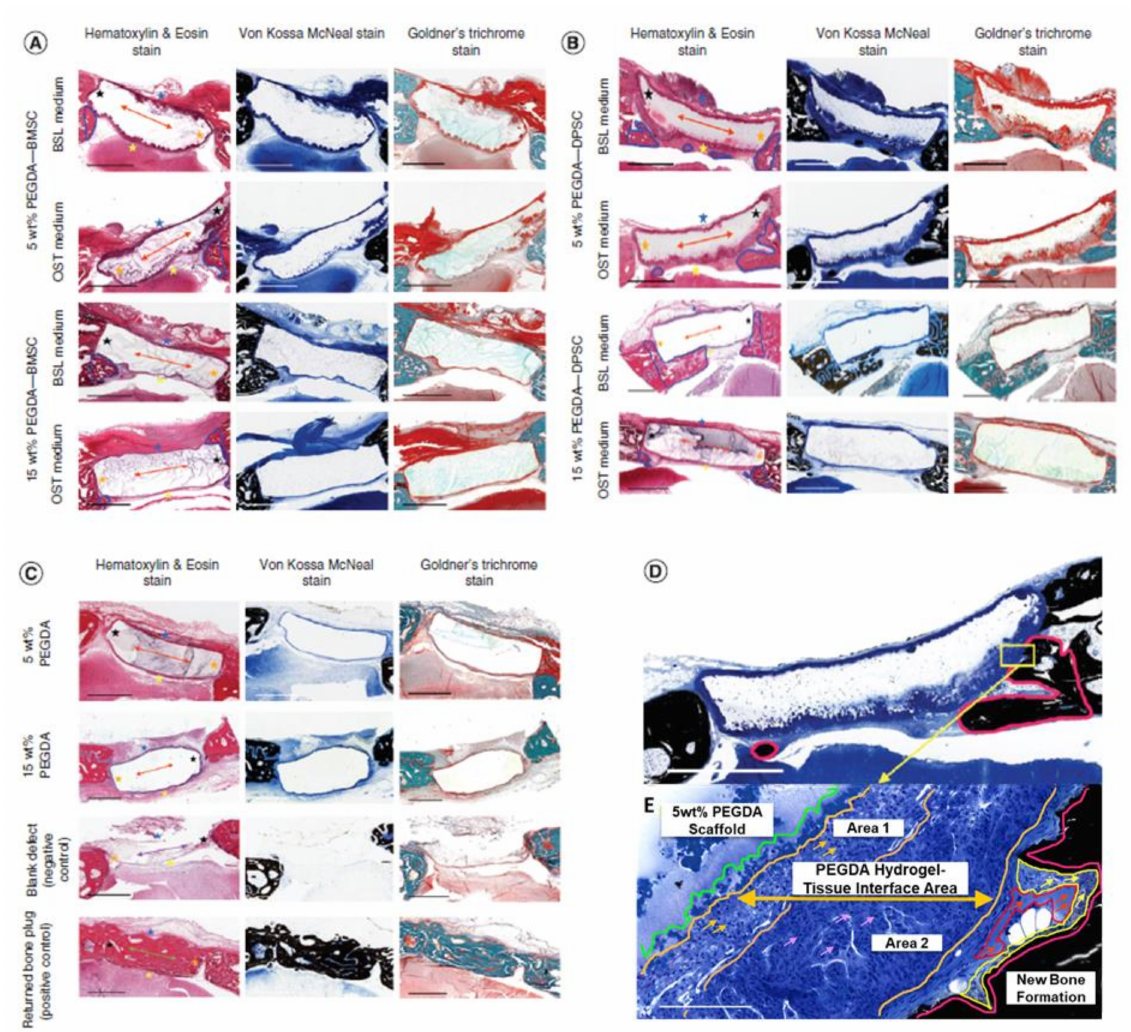
Figure 3. Histological cross-section views of retrieved specimens harvested from calvarial defect model of New Zealand White rabbits, 6 weeks post-implantation. Specimens were collected and stained with Hematoxylin and Eosin (H&E), Von-Kossa MacNeal’s, and Goldner’s Trichrome. ( A ) shows photoencapsulated-BMSCs in 5 or 15 wt% PEGDA hydrogels, cultured in basal (BSL) or osteogenic (OST) medium for 3 days prior to surgery. ( B ) shows photoencapsulated-DPSCs in 5 or 15 wt% PEGDA hydrogels, cultured in basal (BSL) or osteogenic (OST) medium for 3 days prior to surgery. ( C ) shows control groups: 5 or 15 wt% PEGDA hydrogels without MSCs, a blank defect (a negative control group), and a returned bone plug (a positive control group). The blue irregular lines in H&E stain ( A , B ) show new bone tissues. Orange two-sided-arrows in H&E stain ( A – C ) show remaining hydrogel scaffolds, while blue star shows dorsal. Yellow stars show ventral, black star shows medial, and orange star shows lateral. ( D ) shows photoencapsulaed-DPSCs in 5 wt% PEGDA hydrogel. Red irregular line illustrates a new bone tissue. ( E ) is amplification of selected area in ( D ). The green line on upper left side indicates remaining hydrogel scaffold area, while orange lines show the hydrogel-tissue interface area. Orange and pink one-sided arrows in sub-interface areas, one and two, show blue-stained nuclei. One-sided red arrows inside irregular red line areas show osteoid. Scale bar is 2 mm